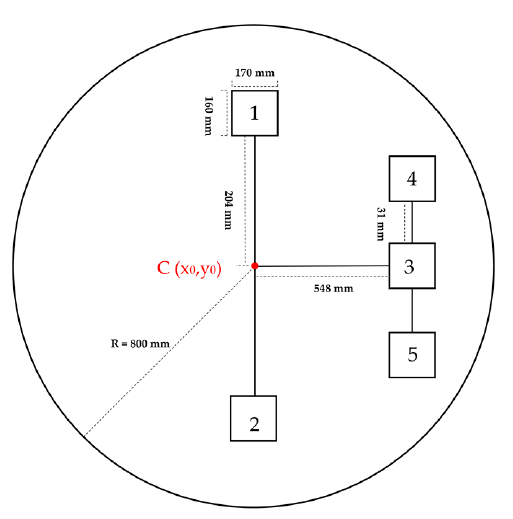
Figure 6. Mean-shift clustering results.